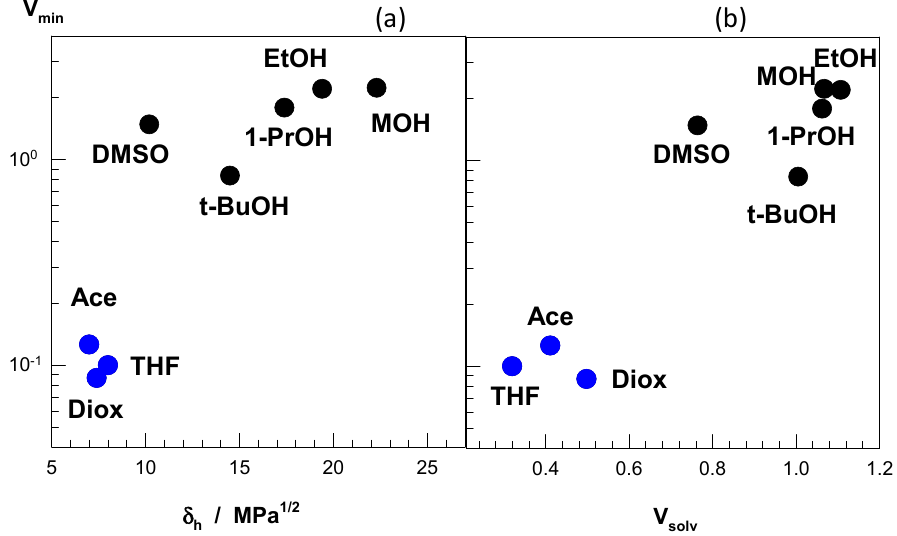
Figure 8. ( a ) The minimum volume (V min ) of nonionic PDMAA hydrogels in water–cosolvent mixtures plotted against the hydrogen-bonding solubility parameter δ h of the cosolvent. ( b ) The dependence of V min on the swelling ratio V solv of PDMAA hydrogels in the pure cosolvent normalized with respect to water. The cosolvents are indicated. MOH, methanol; EtOH, ethanol; 1-PrOH, 1-propanol; t-BuOH, t-butanol; Ace, acetone; Diox, 1,4-dioxane. From [49] with permission from the Elsevier Ltd.